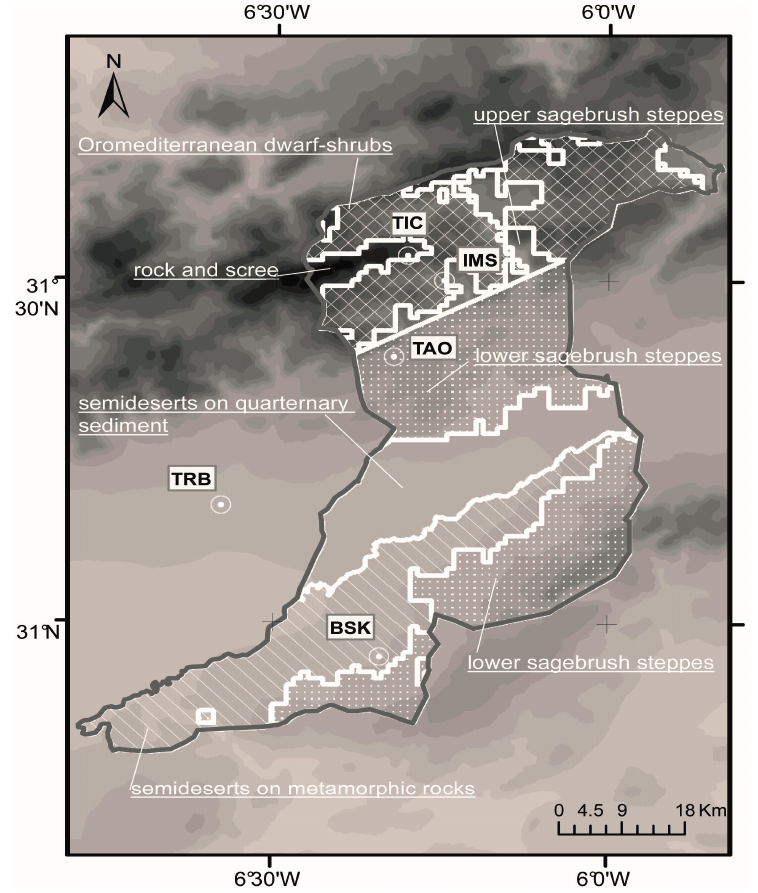
Figure 2. Homogenous response units (HRUs) are established in order to correspond to one of five vegetation types (and tree classes of slope, not shown). The locations of the measurement sites are indicated with white circles (TIC: Tichki, IMS: Ameskar, TAO: Taoujgalt, TRB: Trab Labied, BSK: Bou